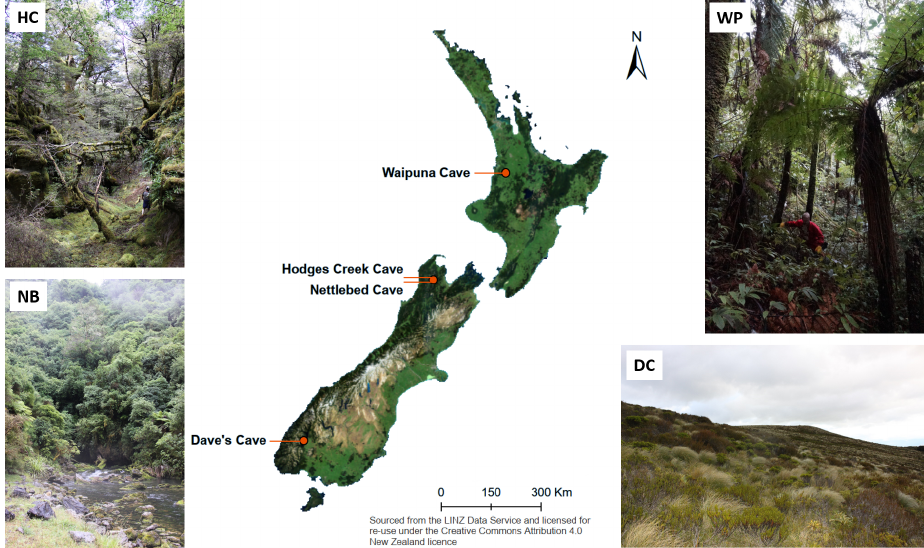
Figure 2. Map of New Zealand with the locations of the caves indicated. The photos give an impression of the vegetation at the sites of Hodges Creek Cave (HC), Waipuna Cave (WP), Nettlebed Cave (NB) and Dave’s Cave